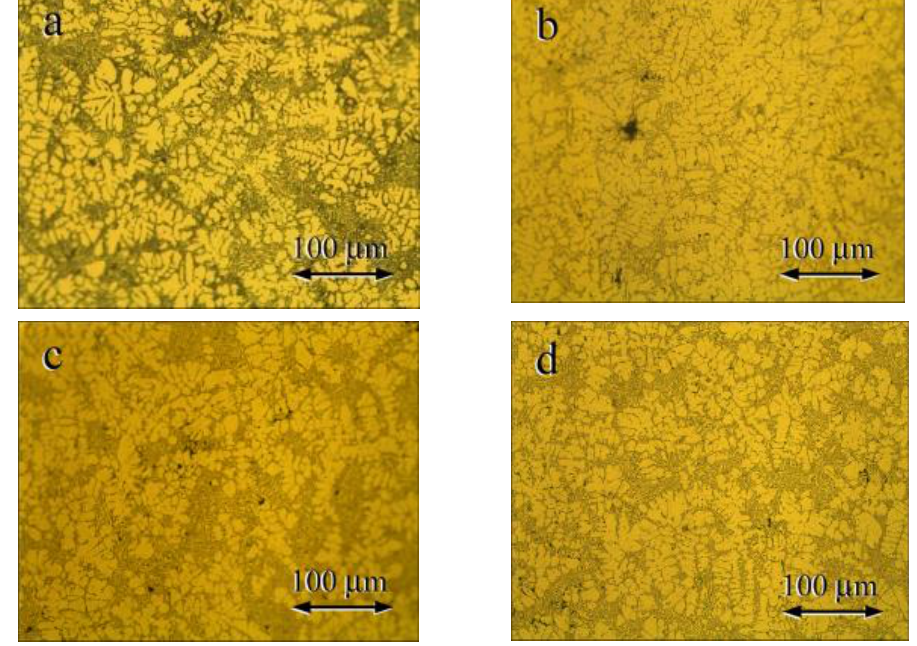
Figure 7. Microstructures of the as-cast Al-10 Si wt.% alloys with the following B contents: ( a ) 0.01 wt.%; ( b ) 0.02 wt.%; ( c ) 0.03 wt.%; and ( d ) 0.05 wt.%.